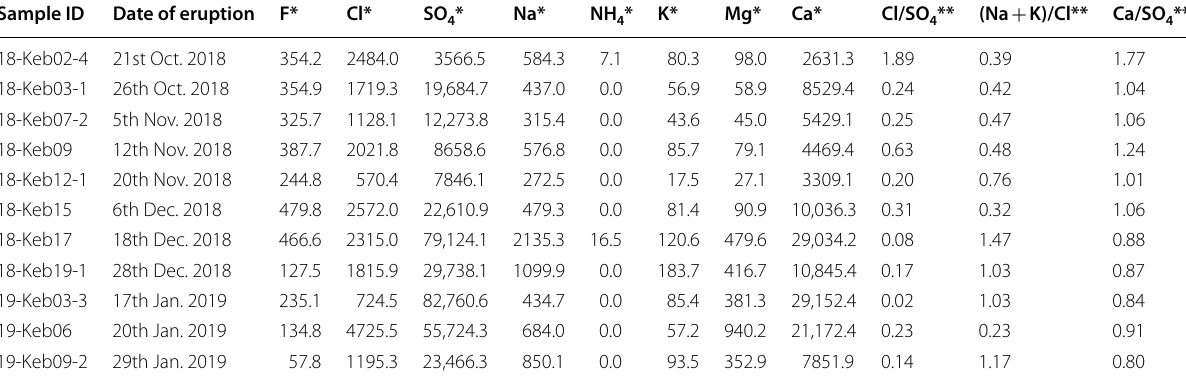
*in mg/kg. **In molar ratio